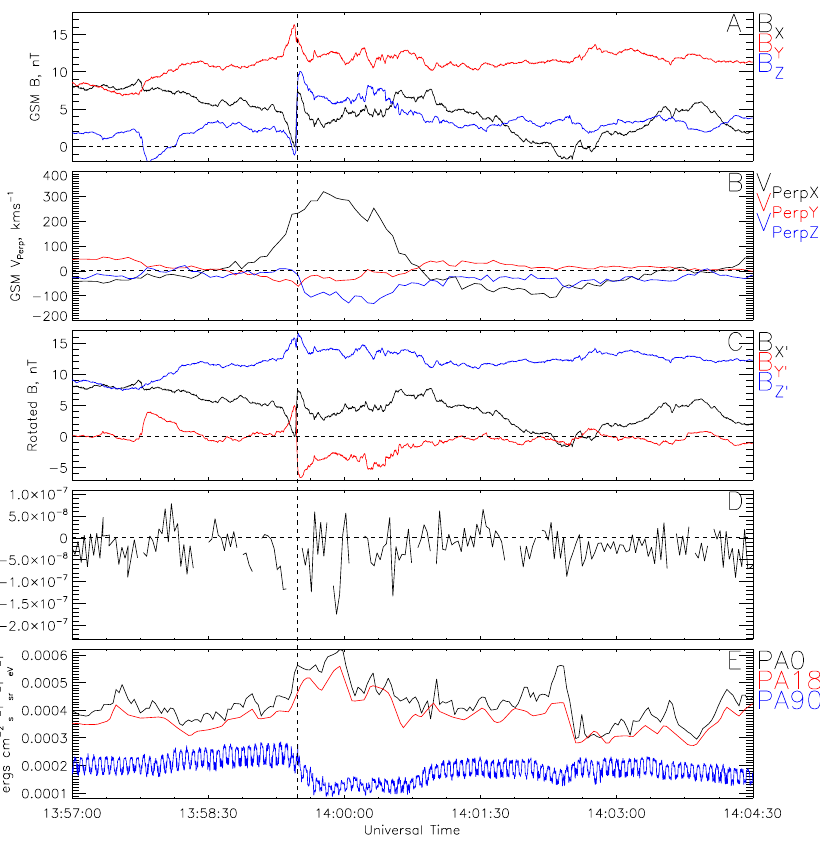
Fig. 11. Data pertaining to the entry of C3 into the plasma bubble. Panel (A) shows GSM components and magnitude of magnetic field, panel (B) the GSM components of V ⊥ , panel (C) the magnetic field rotated about GSM X into a coordinate frame that eliminates any Y component in the undisturbed magnetic field, in order to identify any draping in the field around the plasma bubble. Panel (D) is the parallel electron current calculated from 2-D pitch angle distributions in the energy range covered by both PEACE sensors. Panel (E) shows the electron differential energy fluxes separately for 0 ◦ PA, 180 ◦ PA and 90 ◦ PA, taken from 3-D distributions returned by both the HEEA and LEEA sensors and summed over their common energy range. The vertical dashed line marks the entry of the spacecraft into the plasma